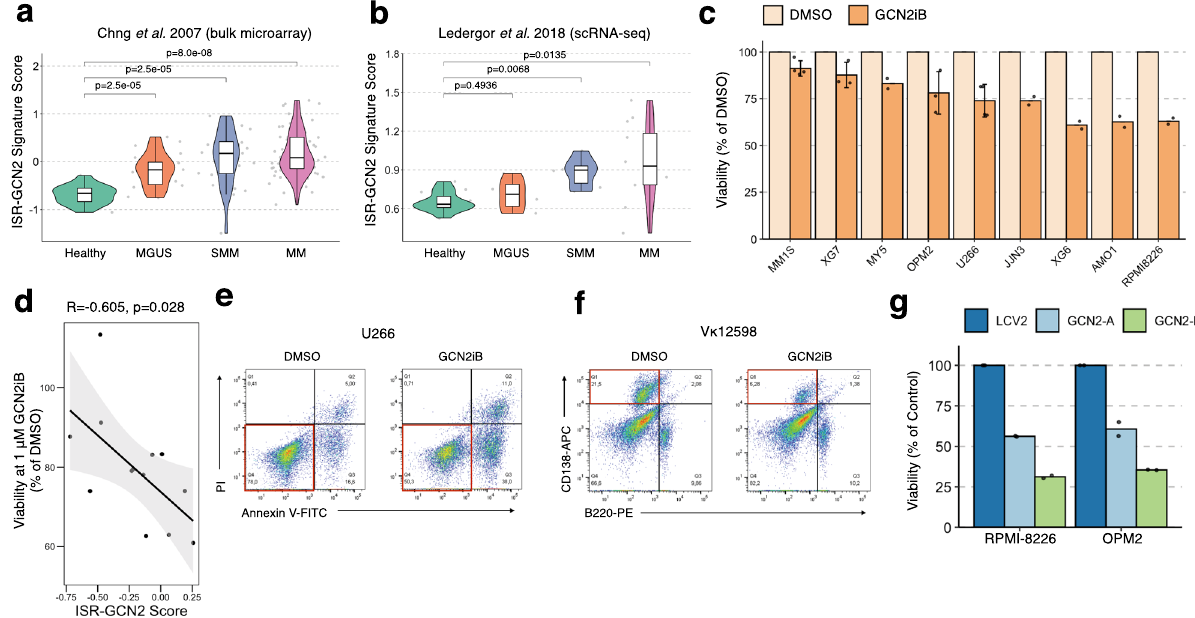
Fig. 6 ISR-GCN2 pathway is progressively activated in myeloma patients and supports myeloma cell survival. a ISR-GCN2 gene signature scoring in publicly-available microarray patient data from Chng et al. 43 calculated by taking the mean of scaled expression values for genes from the ISR-GCN2 gene